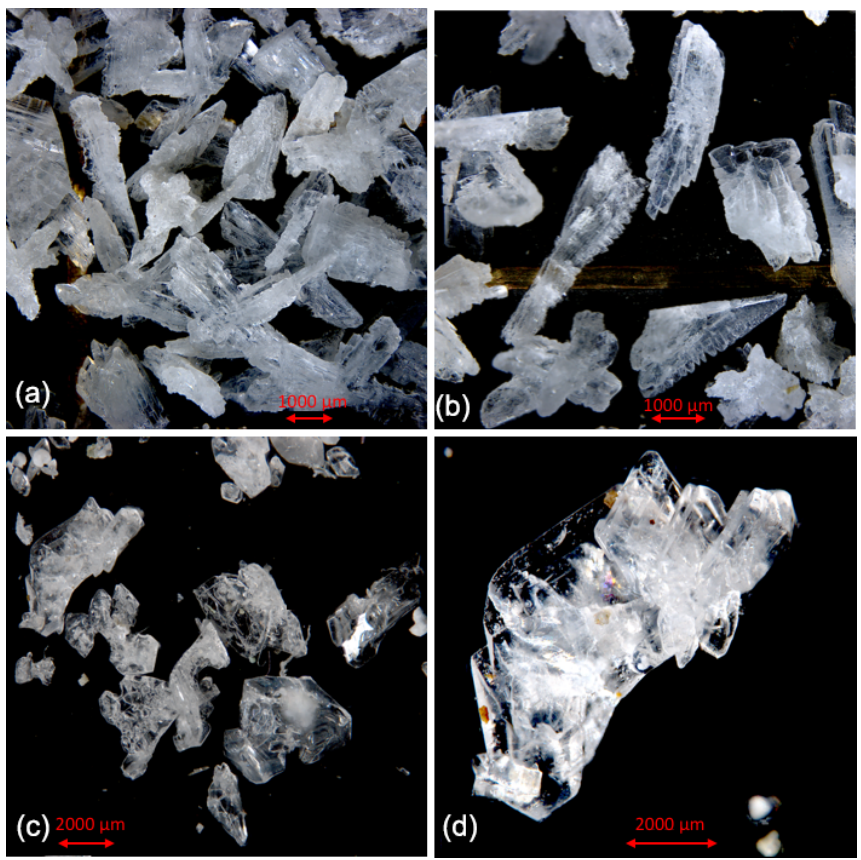
Figure 5. Comparison of cryogenic gypsum crystals collected from the water column at station PS80-2 (10m water depth) (a, b) with crystals retrieved from an ice core collected above the ROVnet sampling area (c, d)